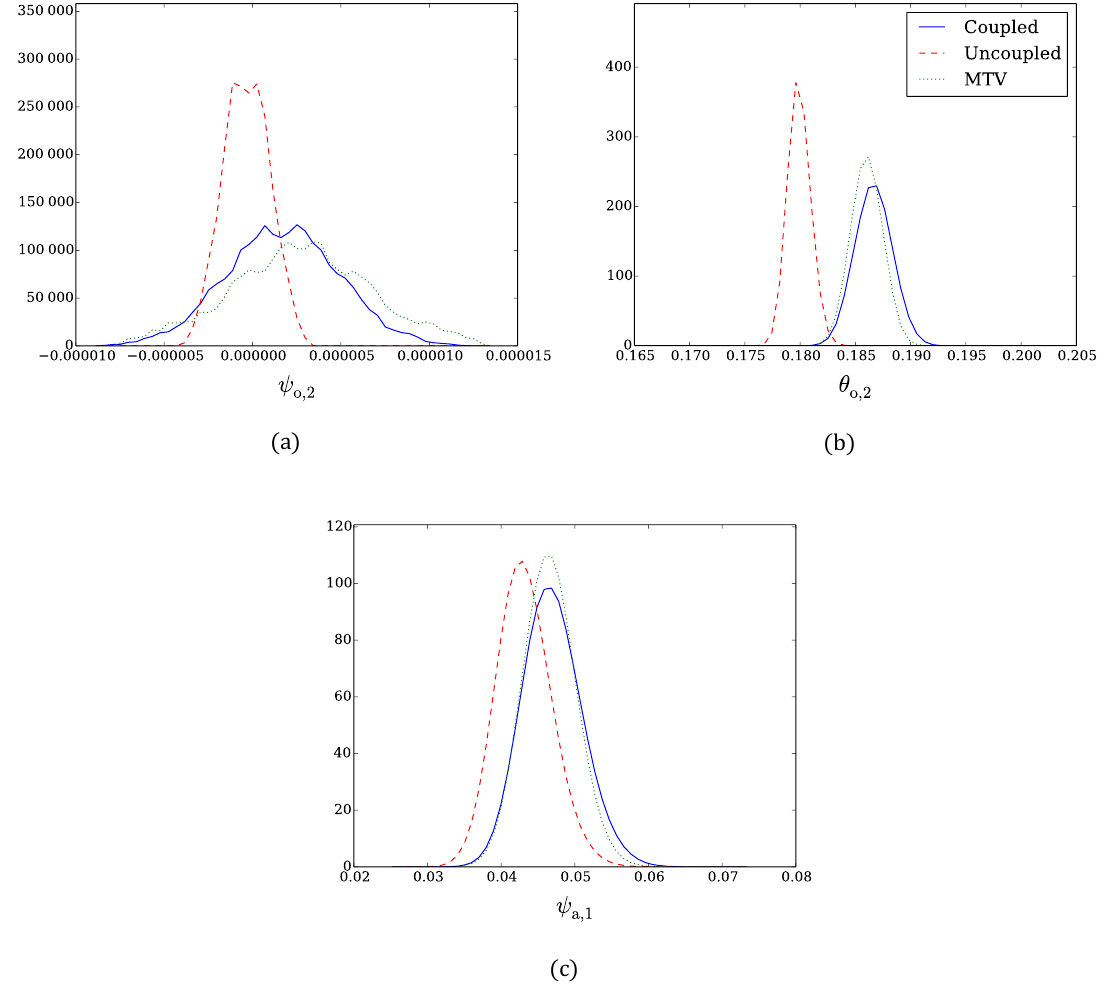
Figure 5. Probability density functions (PDFs) of the dominant variables of the system dynamics as in Fig. 2, but for the wavenumber 2 parameterization and with the parameter set “noLFV”. The WL parameterization results are not shown as it is unstable and